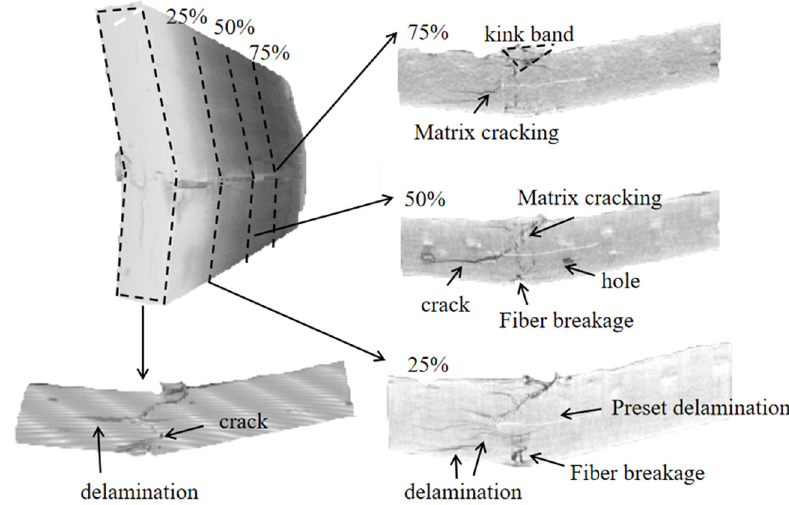
Figure 12: Micro - CT images of failure modes of specimen B at 25, 50, and 75% cross sections in the width